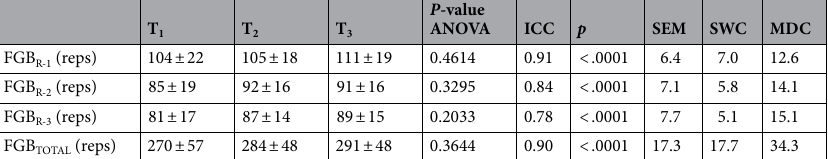
Table 2. Repeatability of Fight Gone Bad performance. FGB R-1 , Fight Gone Bad Round 1; FGB R-2 , Fight Gone Bad Round 2; FGB R-3 , Fight Gone Bad Round 3; FGB TOTAL , Fight Gone Bad total number of repetitions; ICC, interclass correlation coefficient; MDC, minimal detectable change; SEM, standard error of measurement; SWC, smallest worthwhile change.